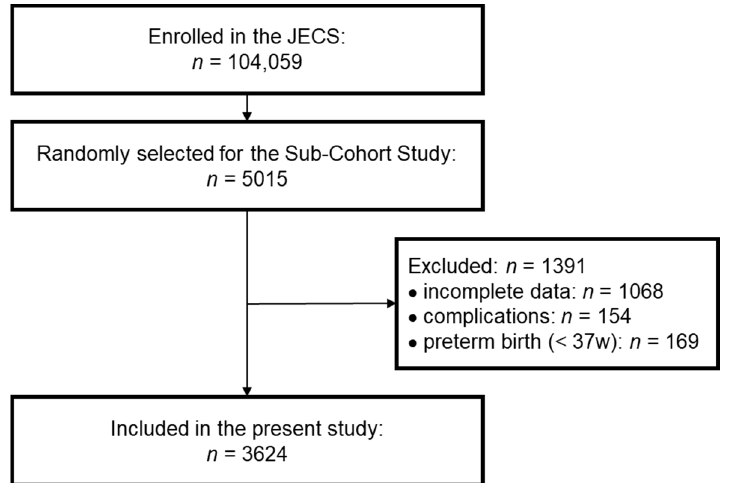
Figure 1. Selection flow diagram. Participants in the Sub-Cohort Study were randomly selected from the Japan Environment and Children’s Study (JECS). Finally, participants who did not meet the exclusion criteria (incomplete data, complications, preterm birth) were included in the present study.